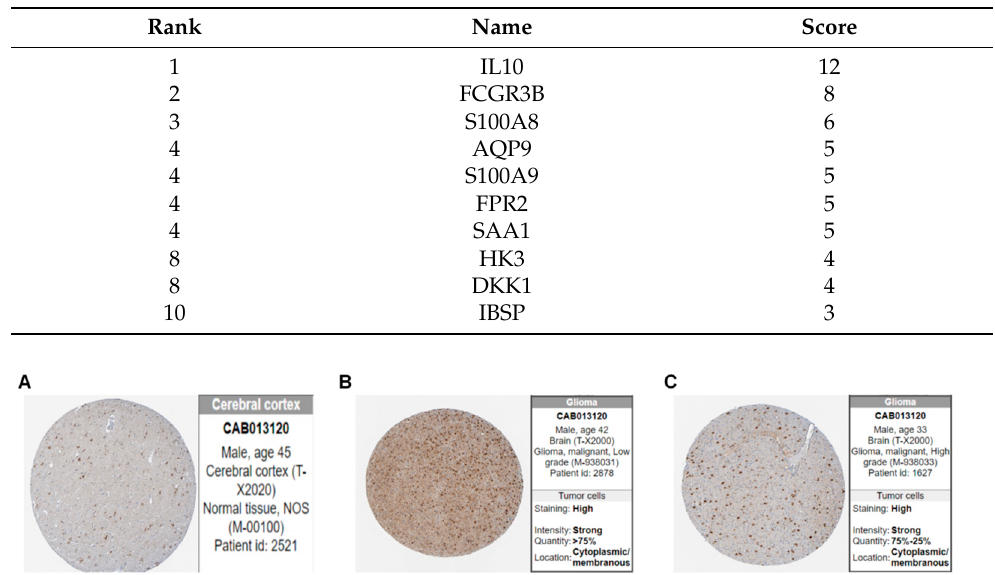
Figure 2. Functional enrichment analysis of differentially expressed genes. ( A – C ) GO and KEGG analysis. ( D , E ) Protein interaction network diagram. The darker the template color, the greater the Table 2. Top 10 genes in the network ranked by the Degree method. interaction score. ( F ) Heatmap of key genes with expression correlations.